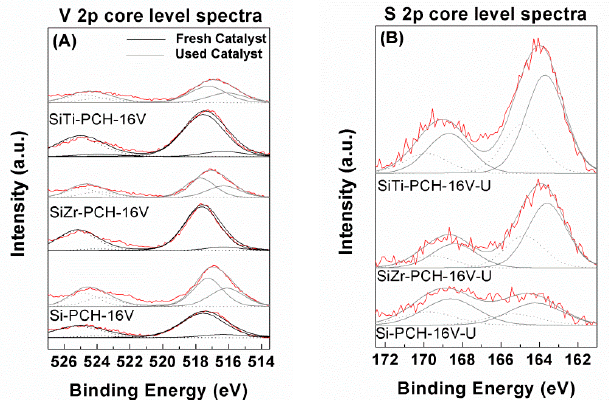
Figure 10. V 2 p core level spectra of Si-PCH-16V, SiZr-PCH-16V and SiTi-PCH16V catalysts before and after selective oxidation of H 2 S reaction ( A ) and S 2p core level spectra of Si-PCH-16V, SiZr-PCH-16V and SiTi-PCH16V catalysts after selective oxidation of H 2 S reaction ( B ). Reaction conditions: 0.05 g of catalyst; total flow of 130 mL min − 1 ; reaction temperature of 180 °C; H 2 S/air/He molar ratio of 1.2/5.0/93.8.